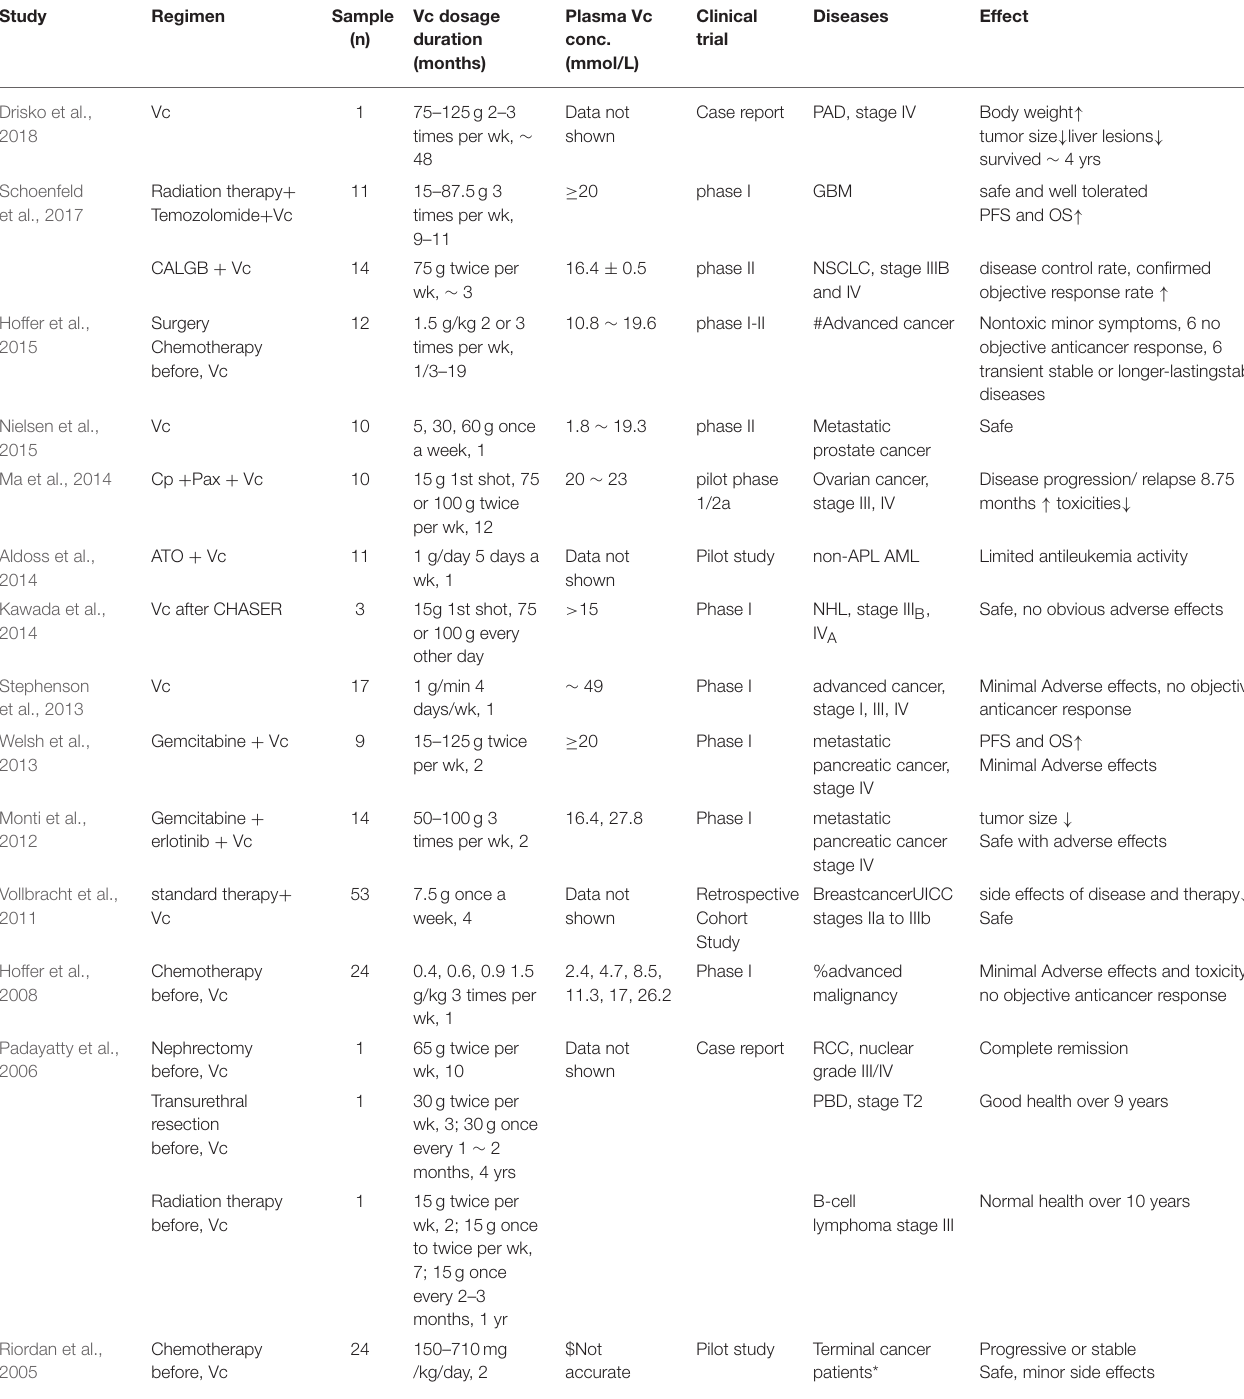
TABLE 4 | Recent clinical use of pharmacological Vitamin C on cancer